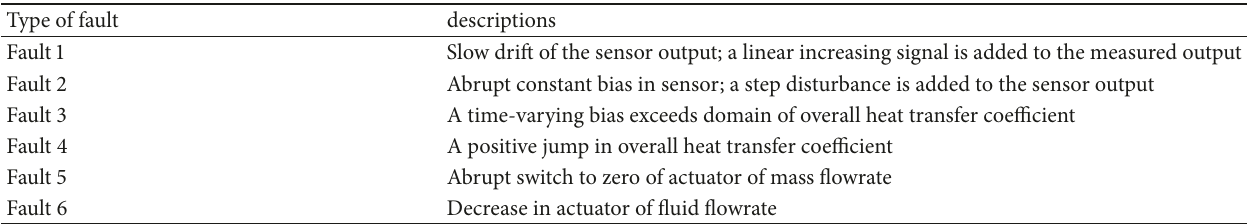
Table 2: Fault scenarios.